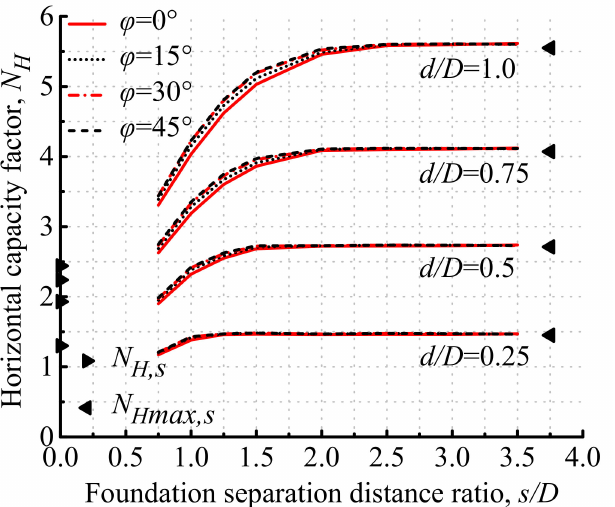
Figure 13. Horizontal capacity factors of tetrapod bucket foundations with various ϕ at κ =